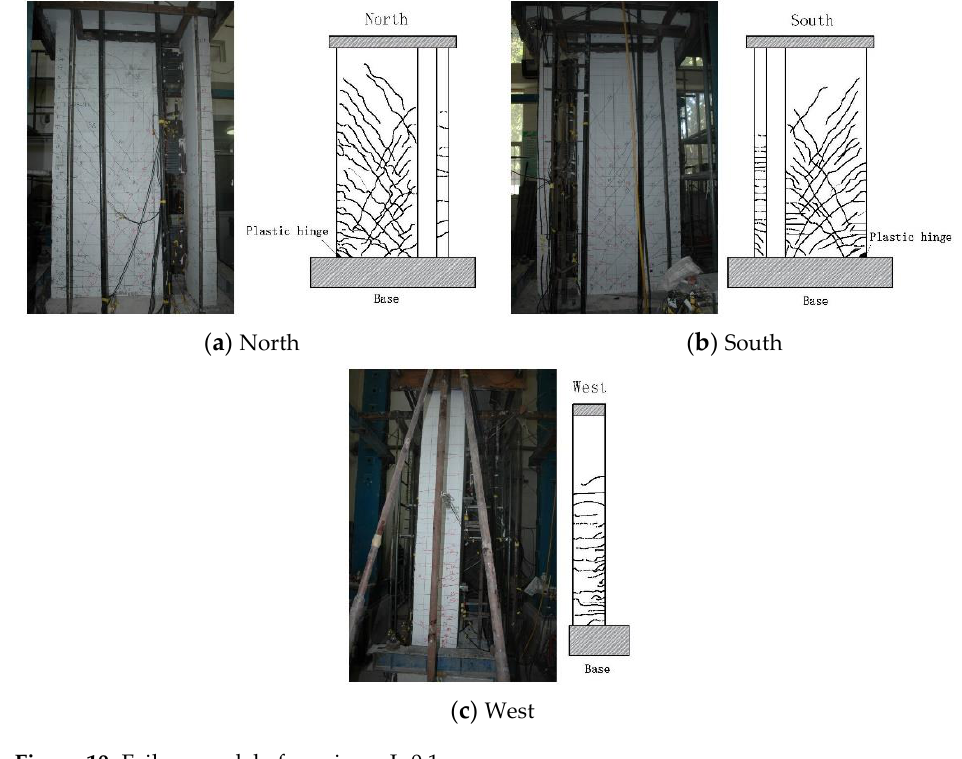
Figure 10. Failure model of specimen L-0.1.